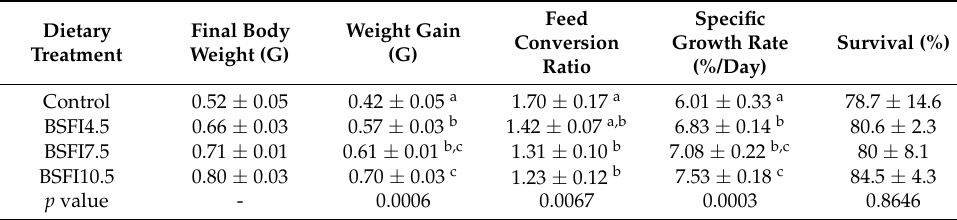
Table 2. Growth performance of Litopenaeus vannamei fed the four experimental diets with different fishmeal replacement levels over 28 days. Values are presented as means ± standard deviations (different superscript letters indicate significant differences ( p < 0.05) between experimental treat- ments. BSFI4.5, BSFI7.5, and BSFI10.5 indicate 30, 50, or 70% of fishmeal replacement with the BSFI,